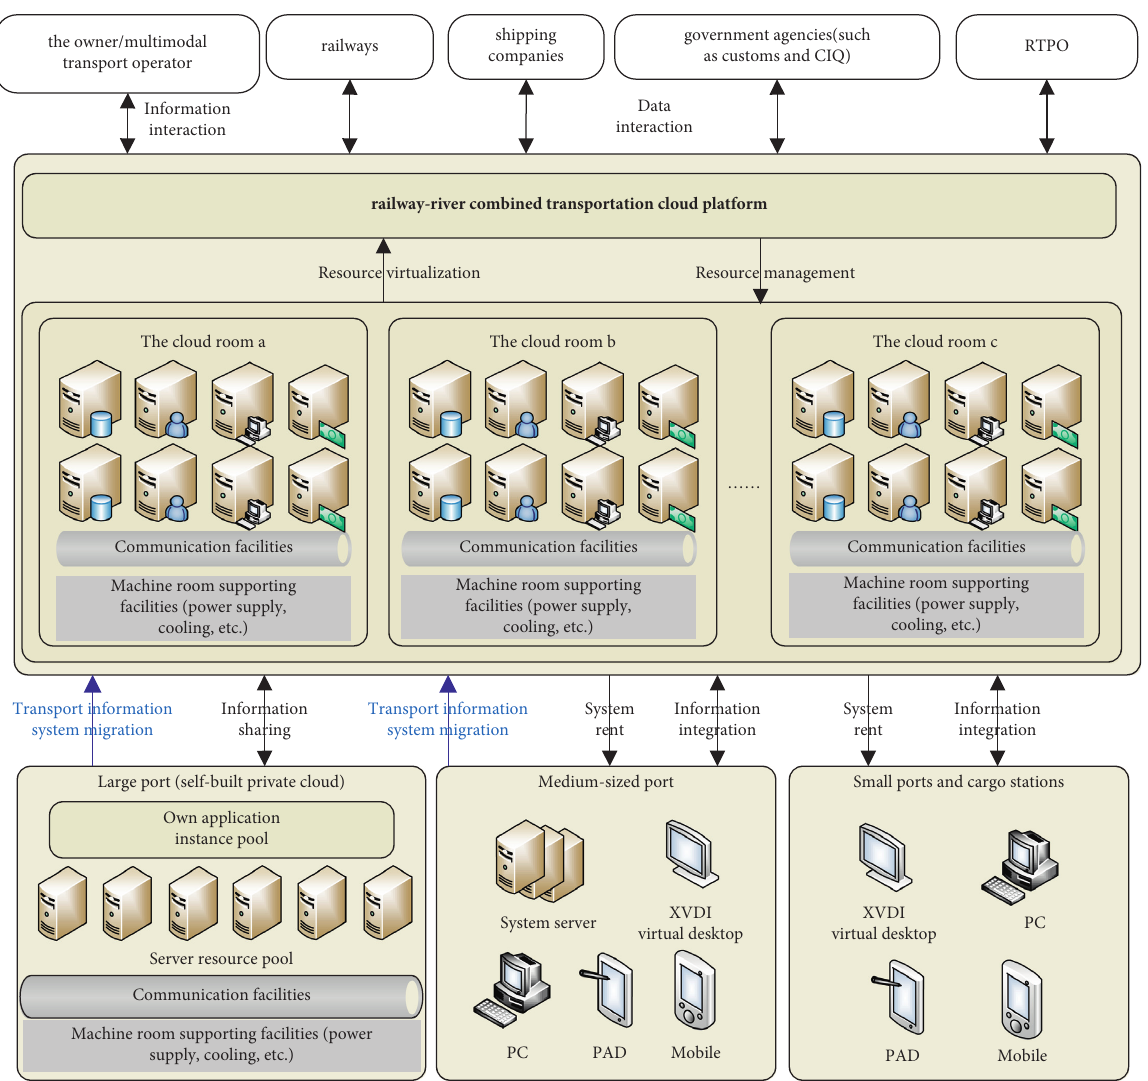
Figure 2: The centralized informatization mode of railway water cloud